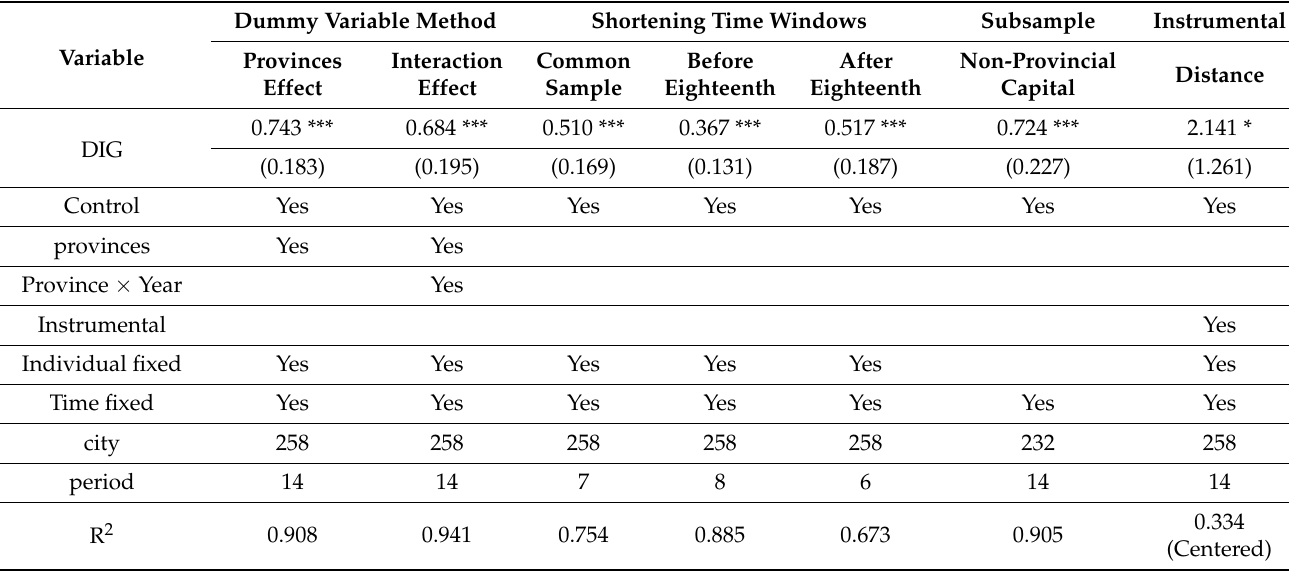
Table 5. Robustness tests for regression